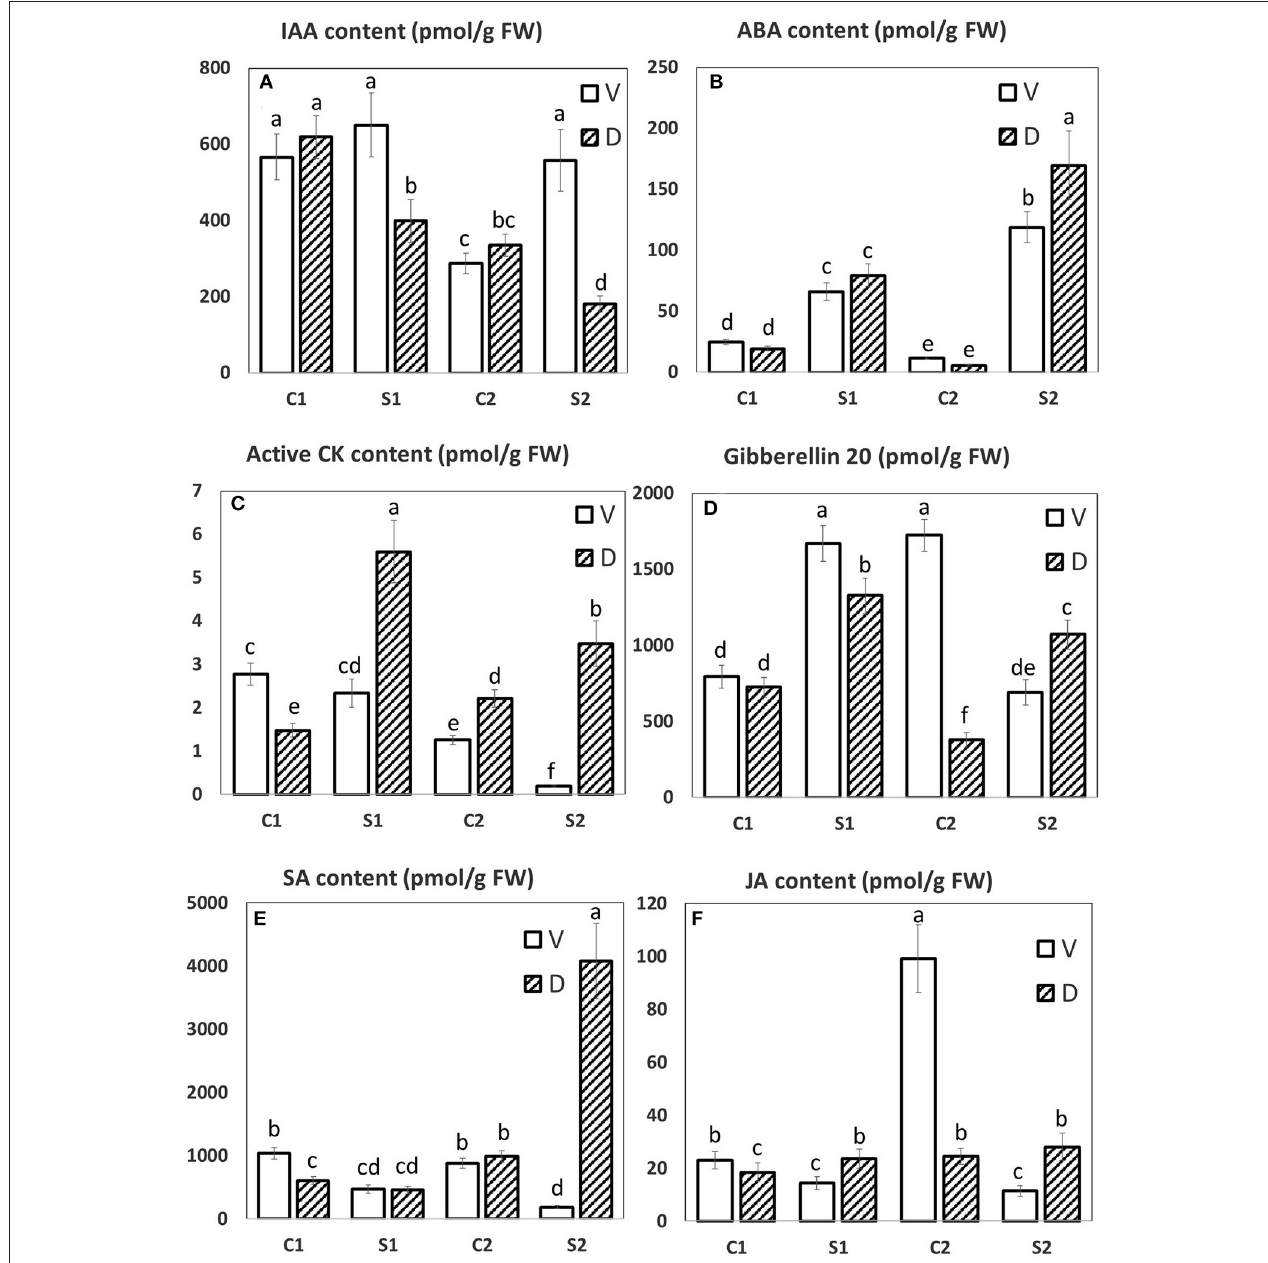
FIGURE 8 | The hormonal profile of MDE. The LC/MS hormonal profile of six selected hormones. (A) IAA, indole-3-acetic acid; (B) ABA, abscisic acid; (C) active CK, active cytokinins; (D) Gibberellin 20, Gb 20 ; (E) SA, salicylic acid; (F) JA, jasmonic acid. Means with different letters show significantly different values between treatments at 5% probability. Error bars denote